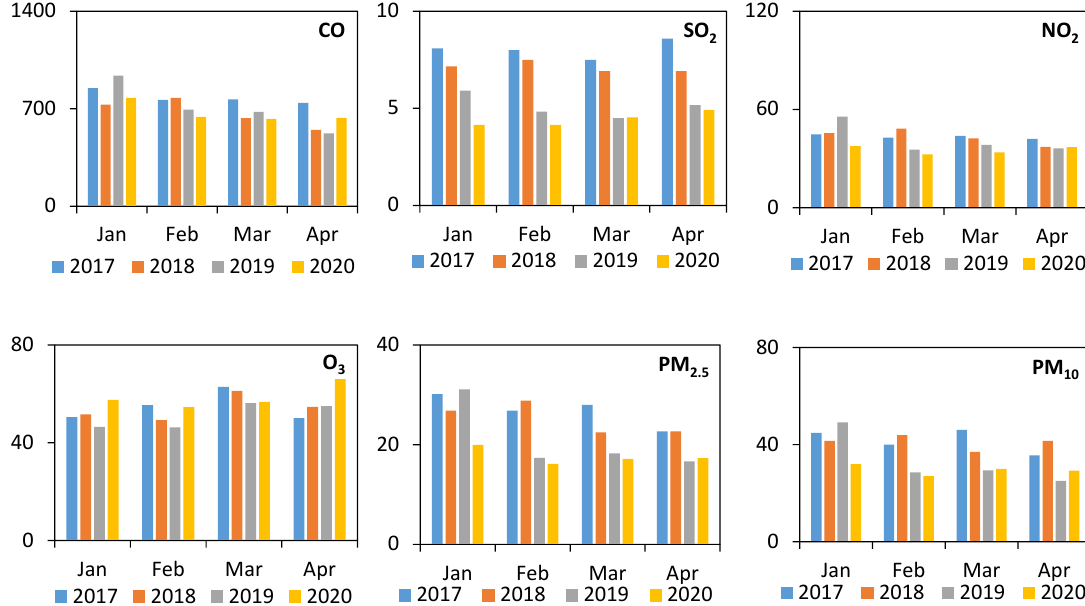
Figure 2. Average ambient pollutant concentrations measured at the 13 ambient air quality monitoring stations. All pollutant units are in μ g/m 3 .